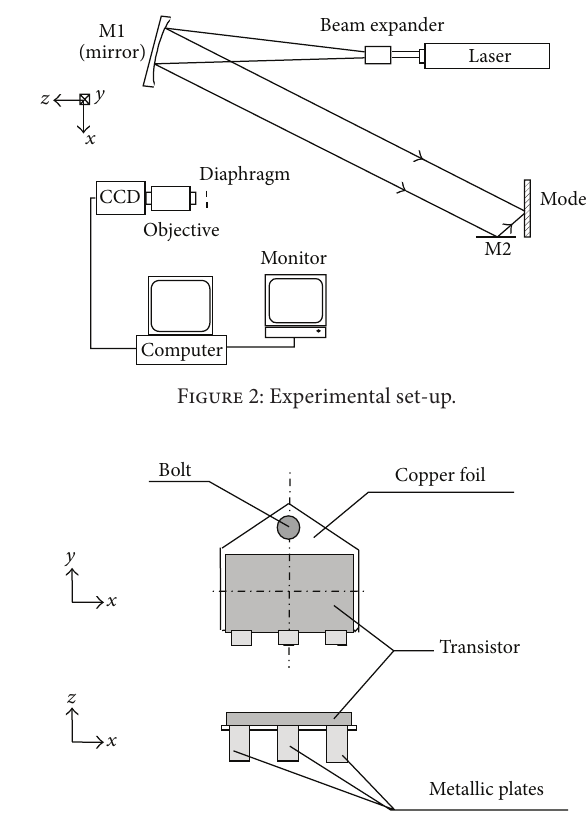
Figure 3: Transistor